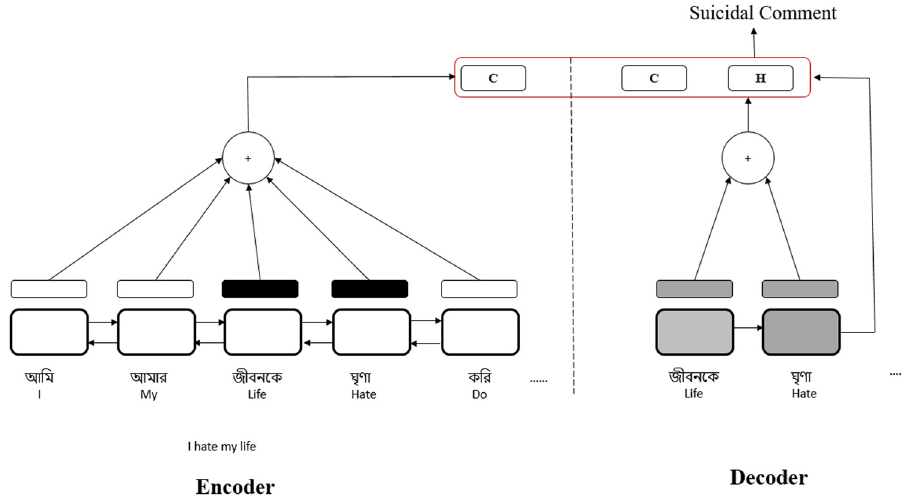
Figure 12: Illustration of the encoder and decoder attention functions combined in Bangla